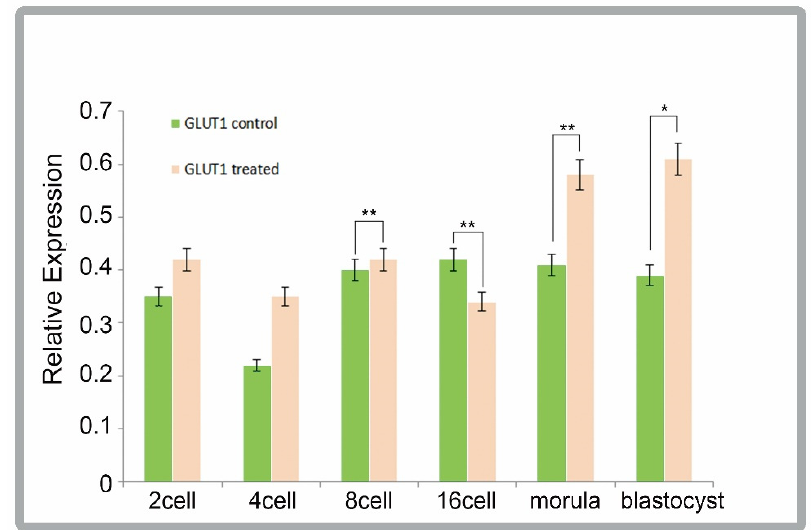
Figure 7. qPCR analysis of GLUT1 in different development stages. Error bars indicate three independent biological replicates (mean ± standard deviation). * p < 0.05, ** p < 0.01.